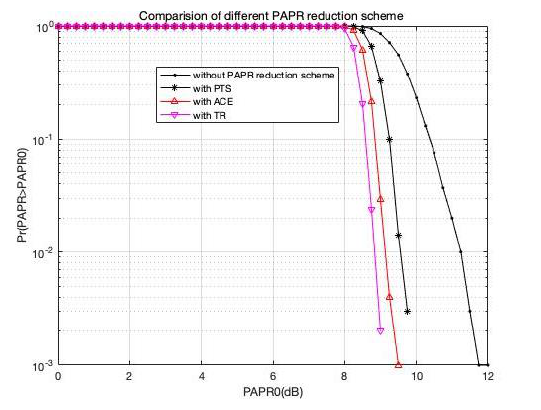
Figure 5. Comparison of different PAPR reduction scheme.